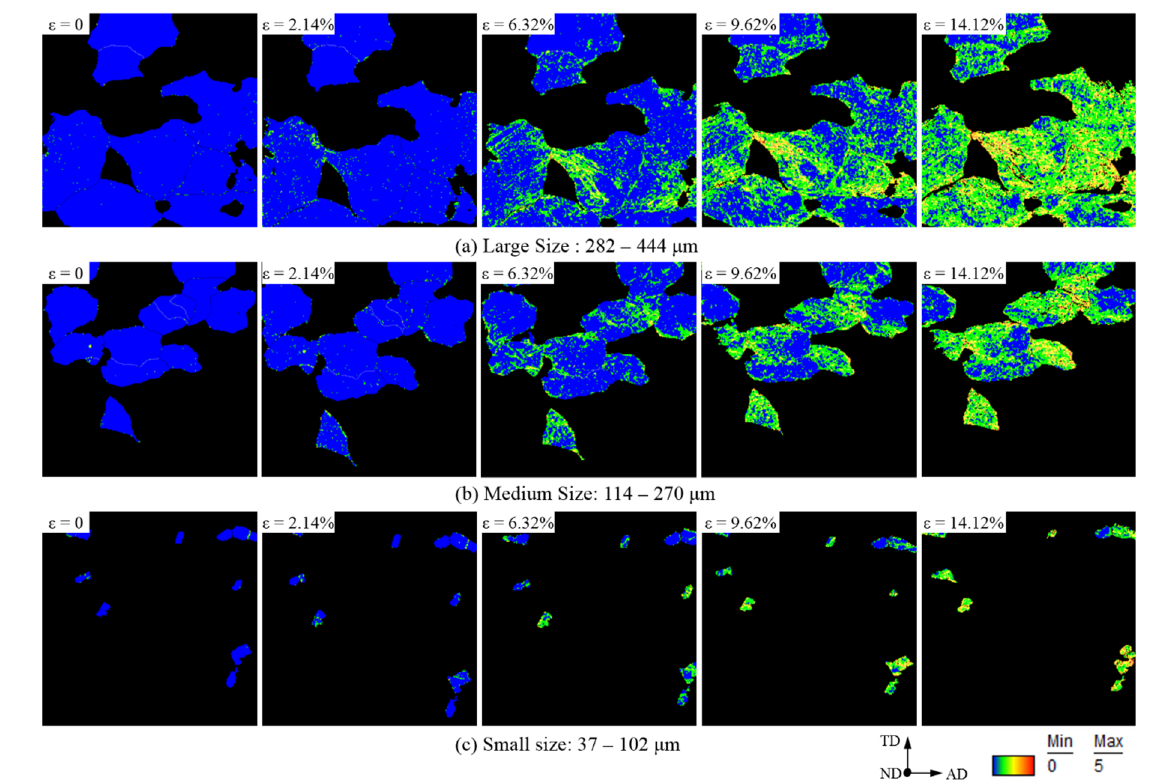
Figure 8. KAM distribution of the observable field observed by EBSD.